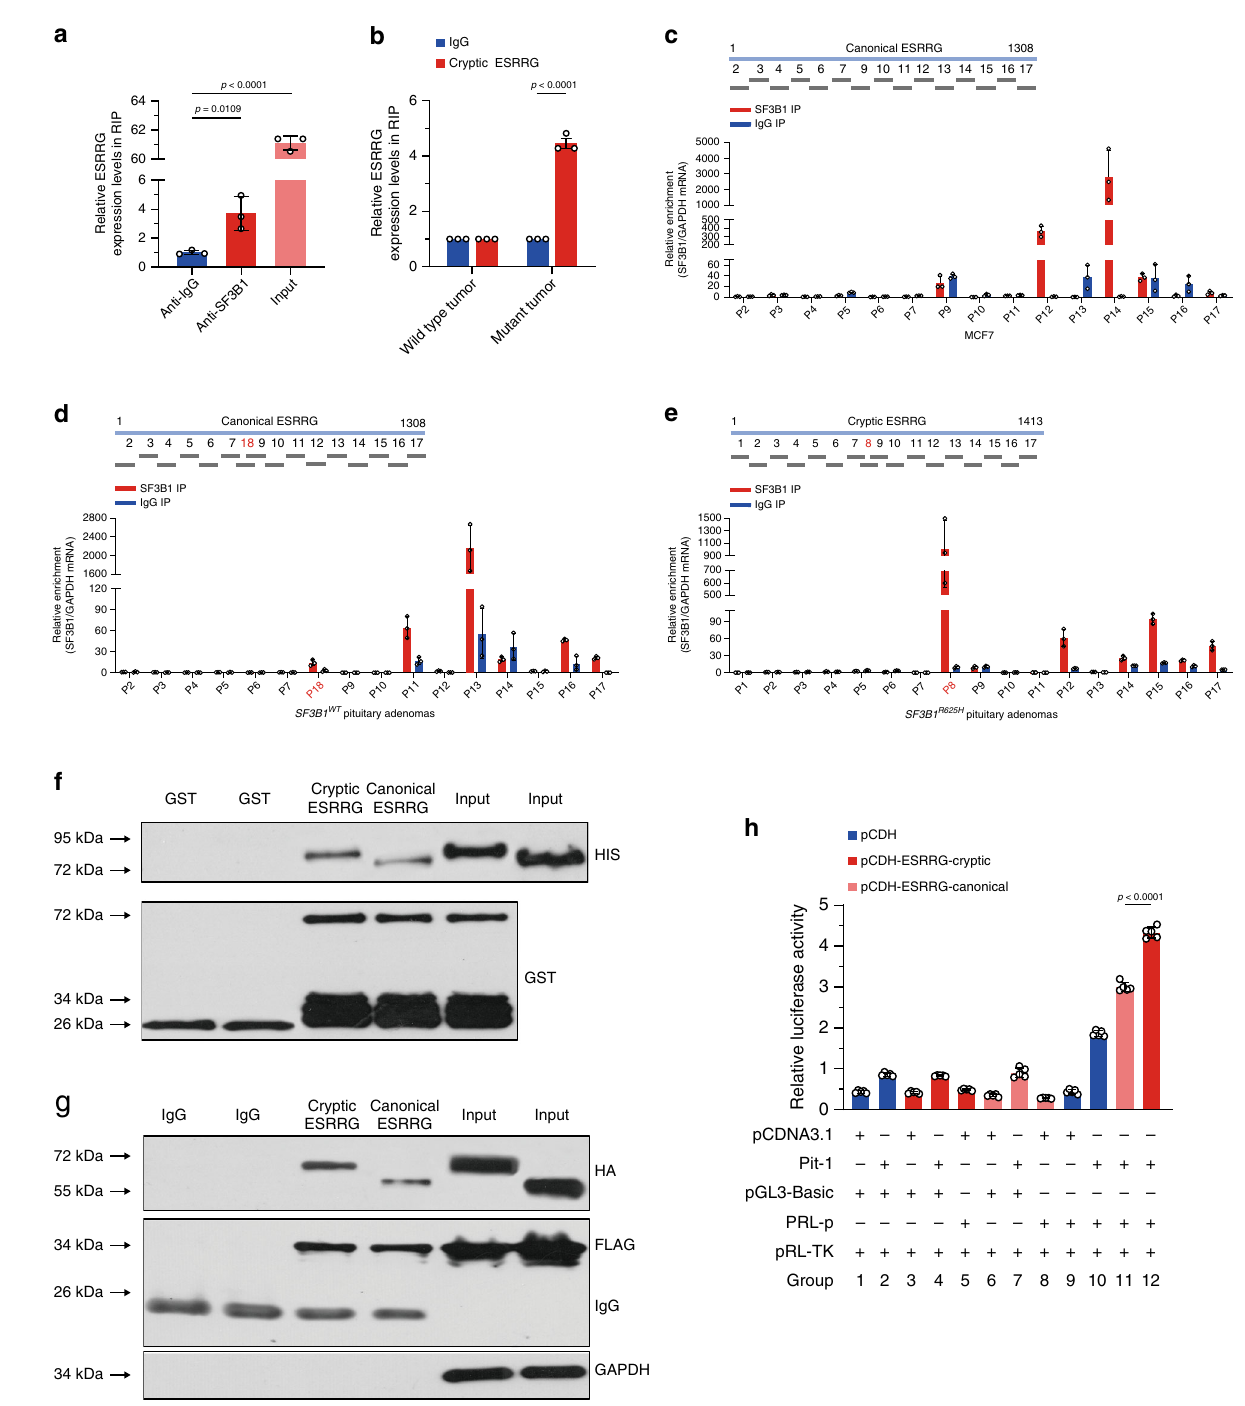
results indicate a physical interaction between Pit-1 and ESRRG in human PA (Supplementary Fig. 9). Then we examined Pit-1 protein binding in relation to ESRRG alternative splicing status. Pit-1 protein fused to glutathione S-transferase (GST) pull-down HIS-tagged cryptic ESRRG, whereas it bound weakly to canonical ESRRG (Fig. 5f). We next co-expressed Flag-tagged Pit-1 HA- tagged ESRRG in human embryonic kidney cells 293 (HEK293) cells and immunoprecipitated them with anti-Flag antibody. As determined by co-immunoprecipitation, cryptic ESRRG binds strongly to Pit-1, whereas canonical ESRRG retained weak binding (Fig. 5g). HEK293 cells were measured by